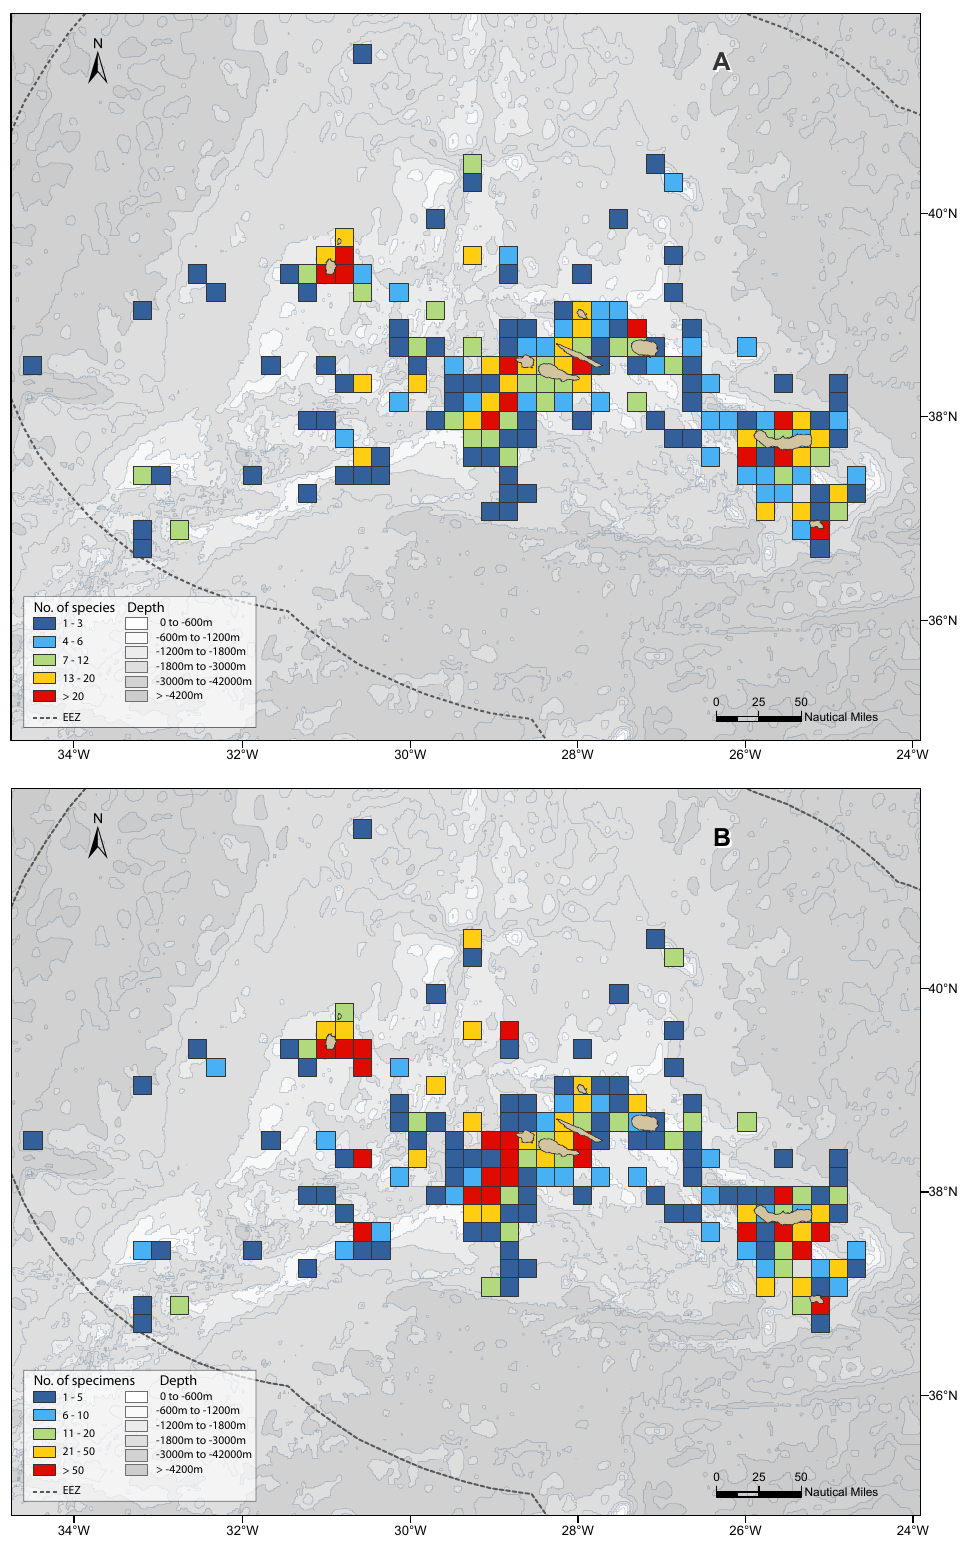
Fig. 4 . Species diversity of corals in the Azores EEZ per 20km × 20km cells. (A) Number of species; (B) number of specimens. Samples comprised 164 species belonging to Alcyonacea, Antipatharia, Scleractinia and